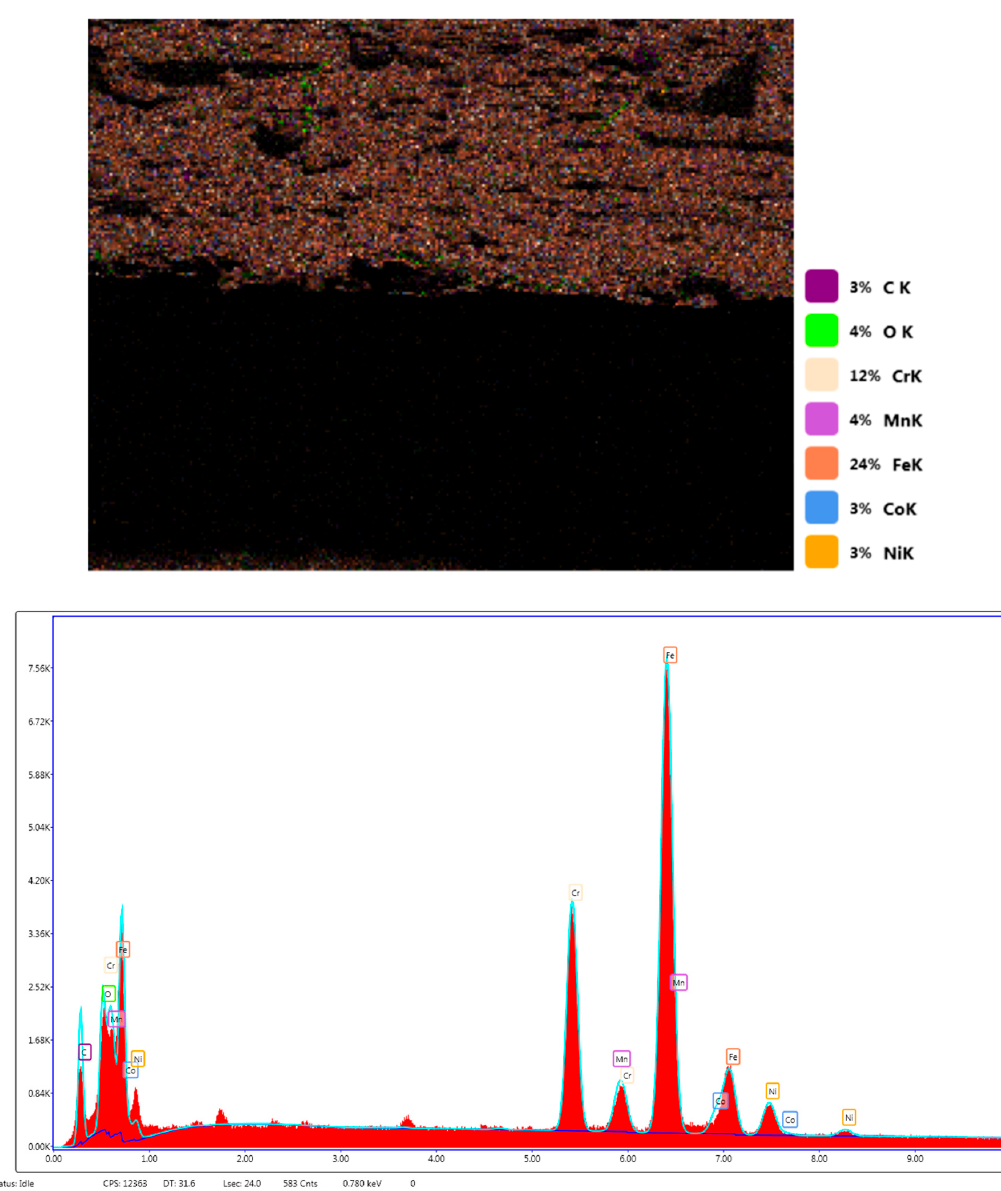
Figure 7. Scanning electron microscope (SEM)/Energy-dispersive X-ray spectroscopy (EDS) investigation indicates the presence of